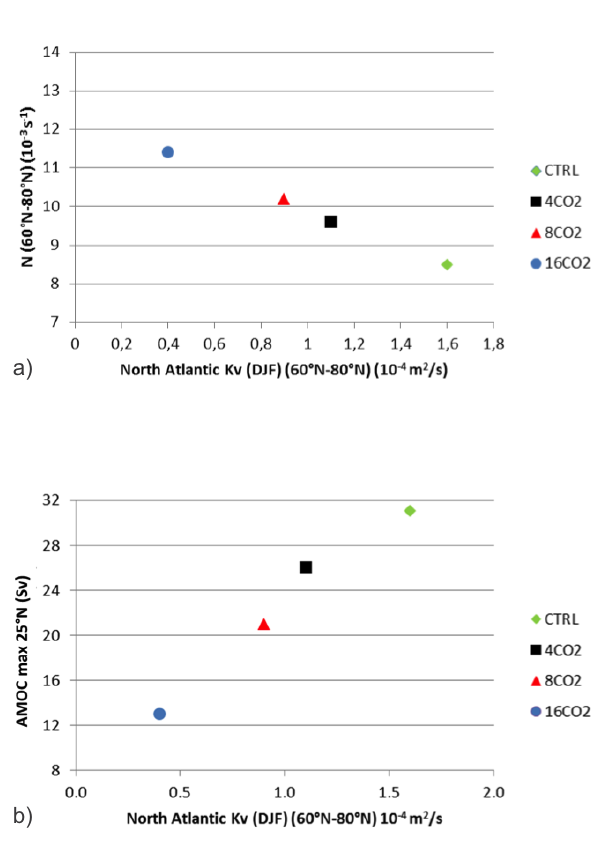
Figure 12. North Atlantic (averaged between 60°N-80°N) winter mean vertical diffusivity (10 -4 m 2 /s) integrated between 100-2000 m depth, (a) versus buoyancy frequency N (10 -3 s -1 ) around pycnocline depth (i.e. between 50 and 100 m) and (b) versus AMOC max inten- (black sity computed at 25°N for CTRL (green diamond), 4CO 2 square), 8CO (red triangle) and 16CO (blue circle) 2 2